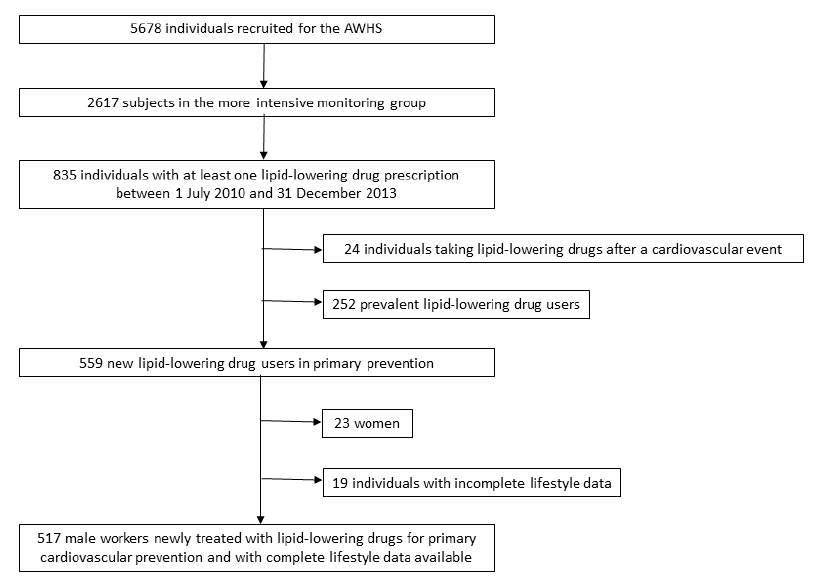
Figure 1. Flowchart of the study population.